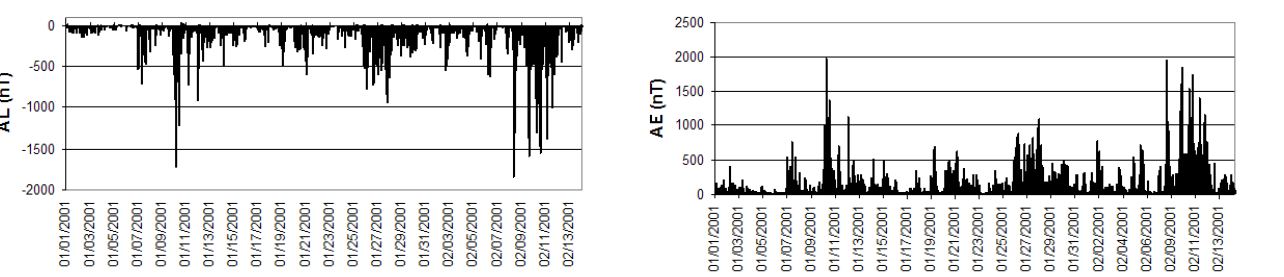
Fig. 3. AE index for the period between 1 January and 15 February 2001 (collected at 1min